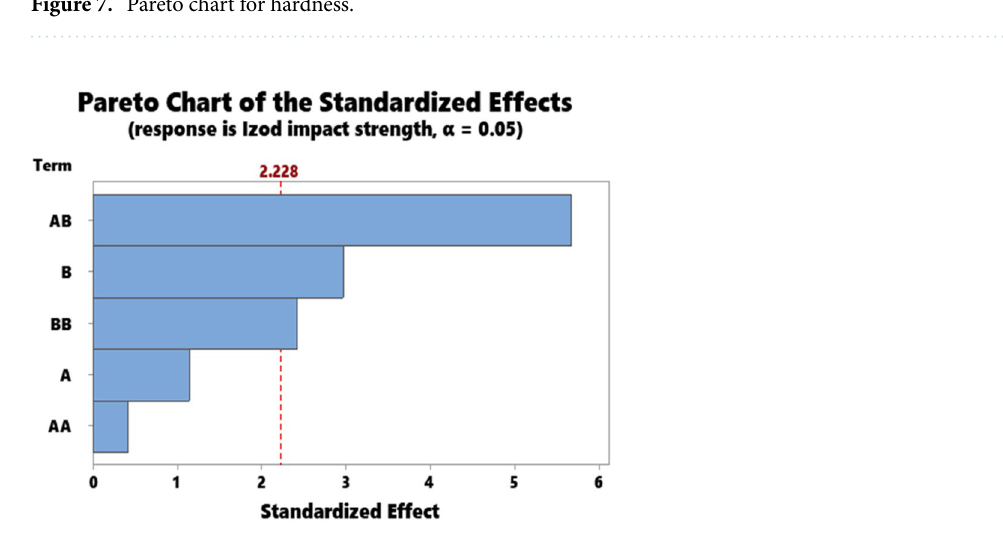
Figure 8. Pareto chart for impact